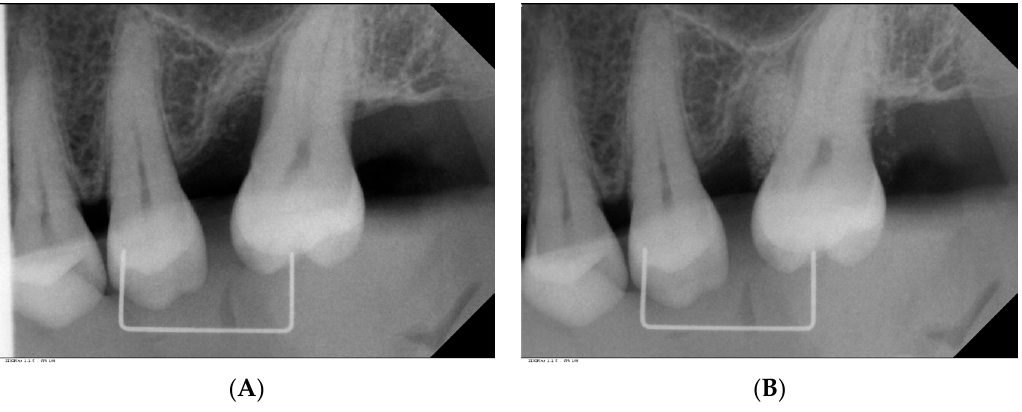
Figure 5. Pre- and post-surgical radiographs (EMD/BCP group). ( A ) Deep vertical infra-bony defect is visible on the mesial aspect of tooth 27; ( B ) The bone defect is filled with radio-opaque bone substitute (BCP) beyond the residual contour of the alveolar crest.